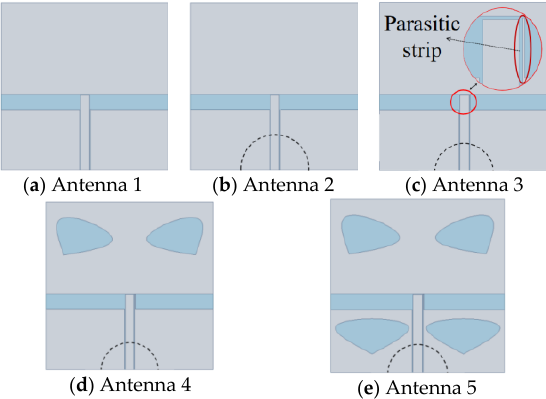
Figure 4. Geometry comparison of five types of antennas.